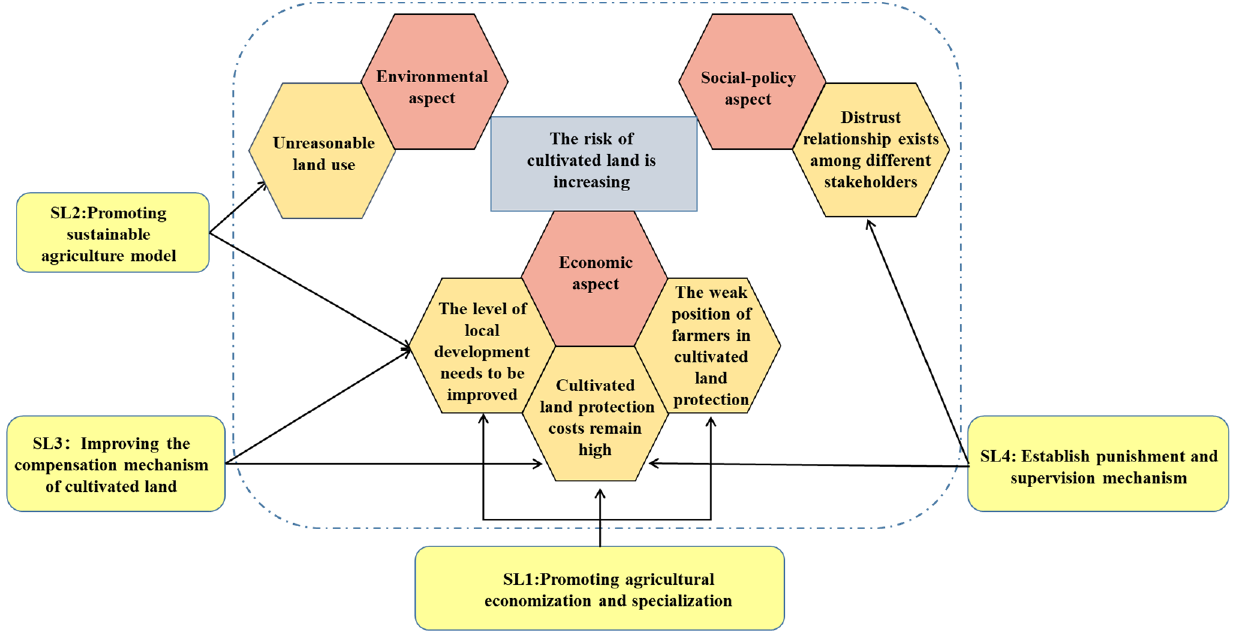
Figure 5. Framework for mitigating risk.